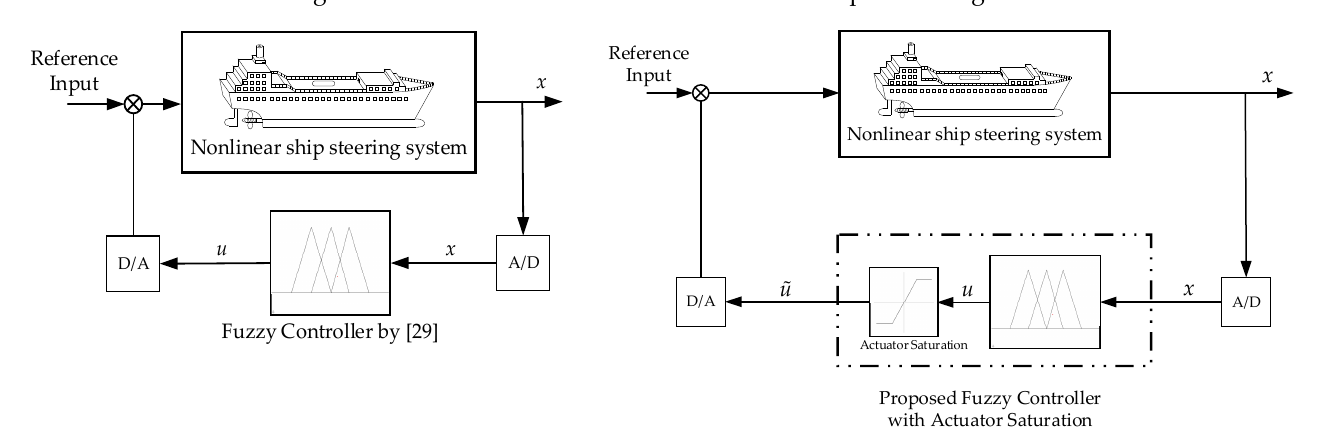
Figure 3. Block-diagrams of the control ship steering system.